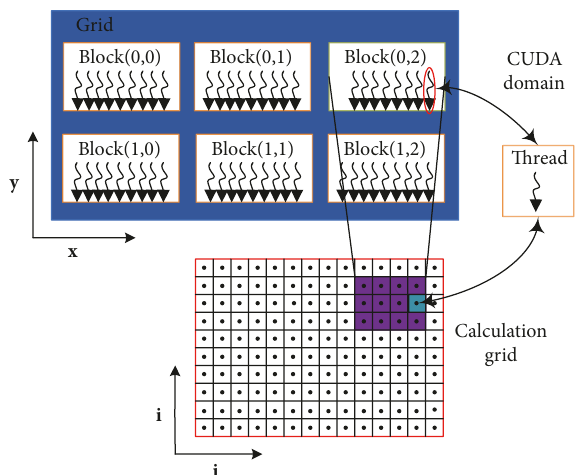
Figure 5: Mapping between the real domain and the CUDA grid of thread blocks.